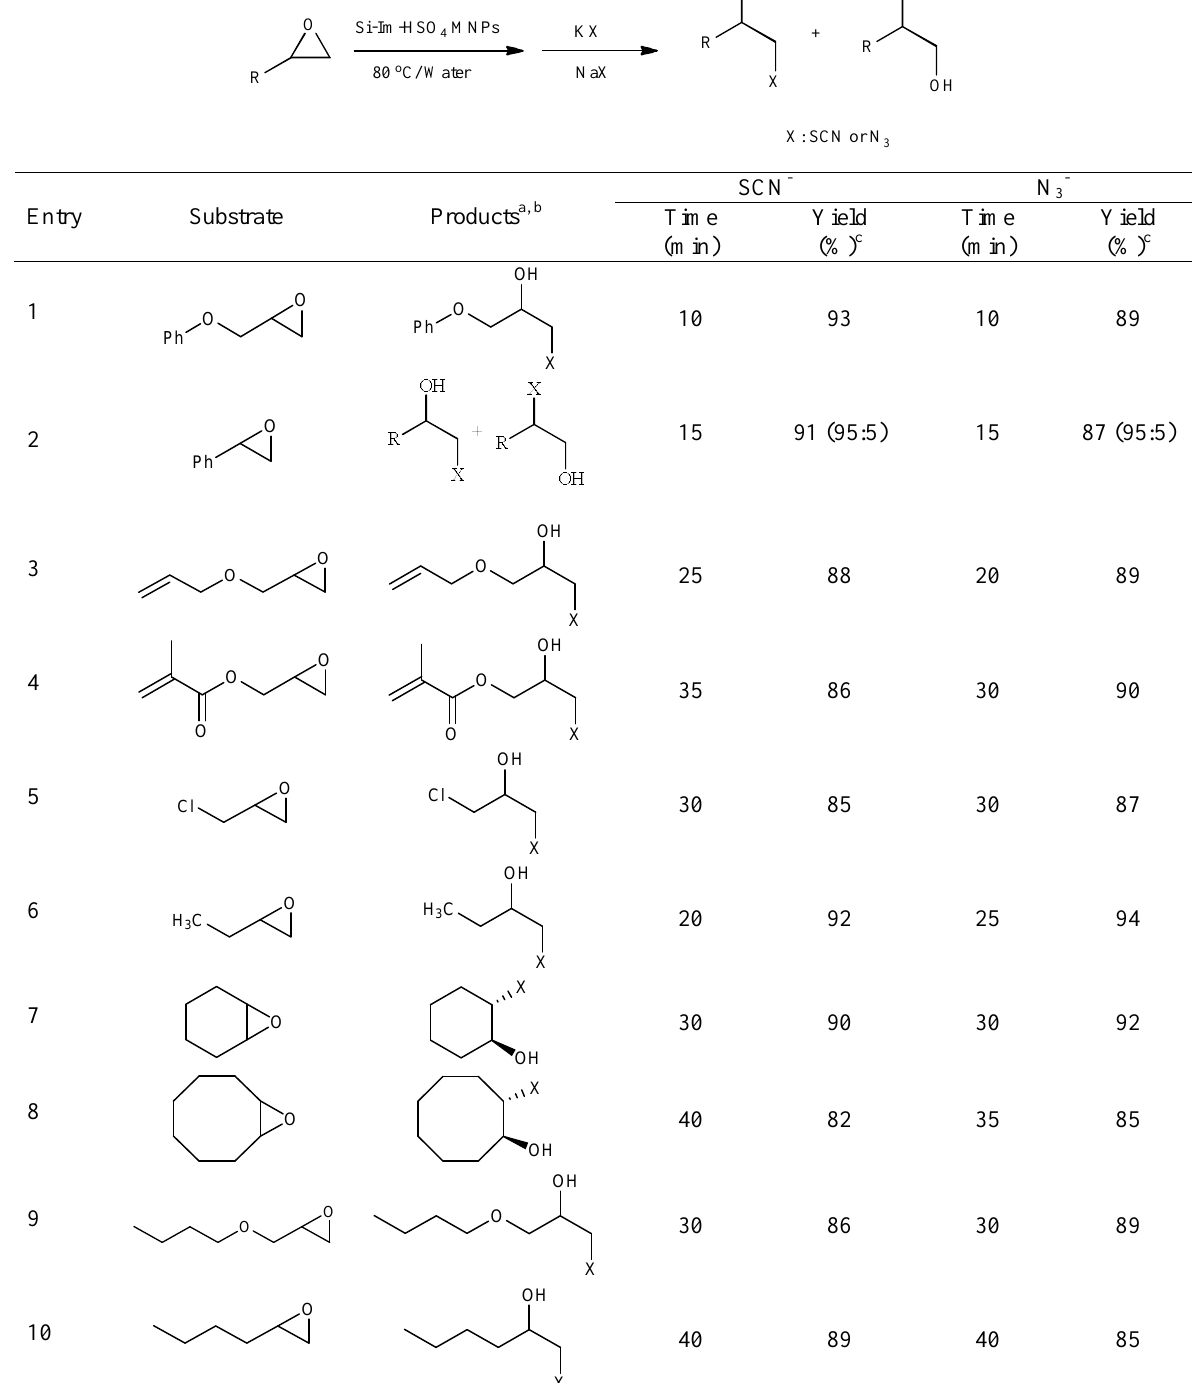
MNPs in Water 4 R